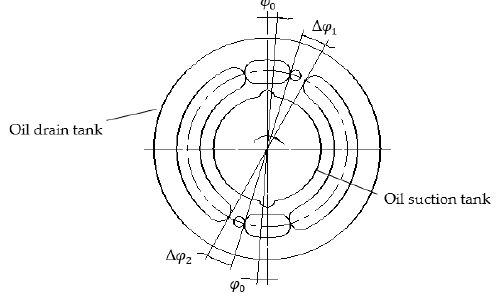
Figure 1. The typical symmetric port plate structure.